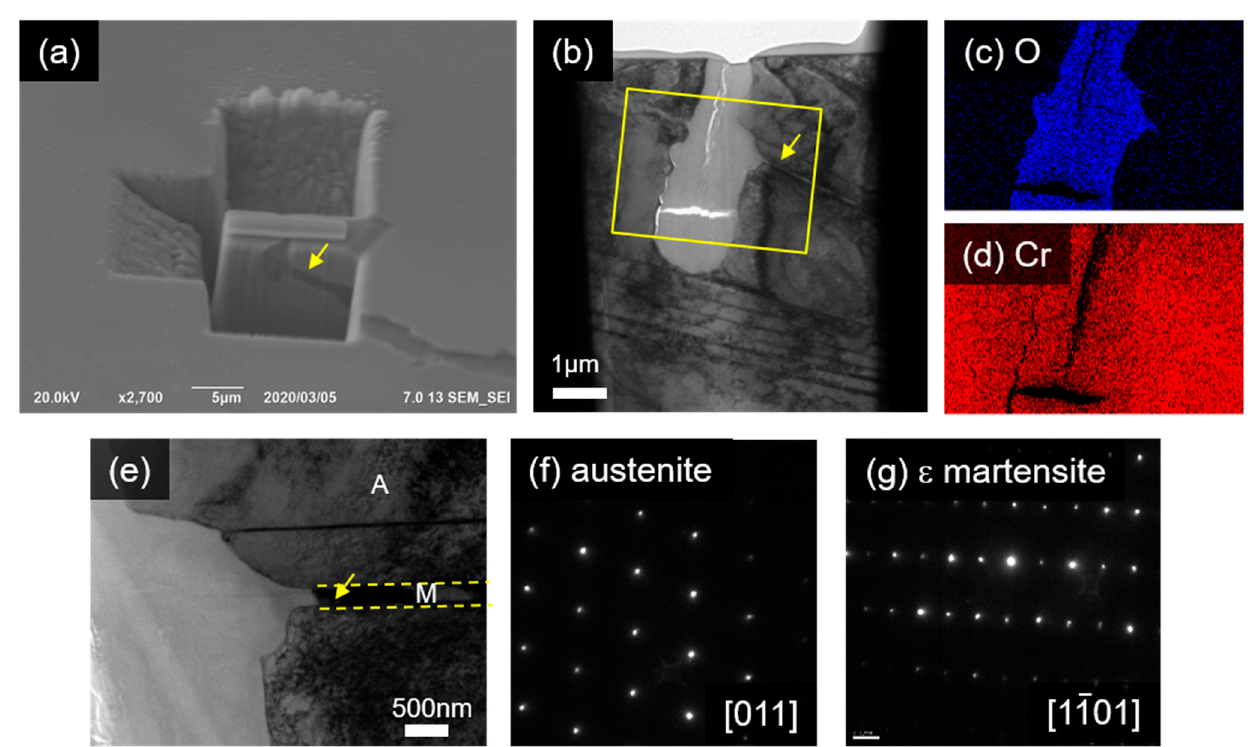
Figure 7. TEM foil is achieved from the area contains tip of micro crack shown in ( a ). ( b ) TEM BF image obtained from area ( a ). ( c , d ) EDS map obtained from region indicated with yellow box in ( b ). It shows Cr rich oxide. ( e ) Enlarged image of ( b ) shows that the crack changes direction along specific band. ( f , g ) Nano beam electron diffraction pattern obtained from region denoted by A and M in ( e ), respectively.